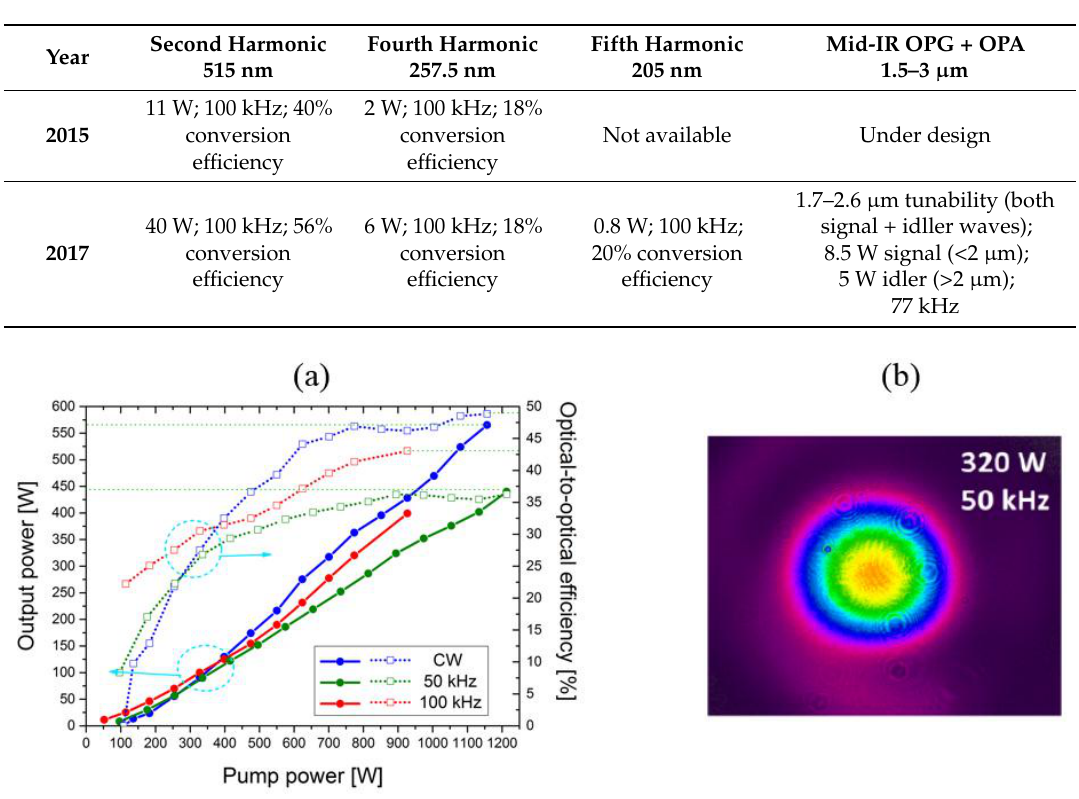
Table 2. Comparison of progress in typical average output power, pulse repetition rate, and conversion efficiency of frequency up- and down-conversion stages pumped by the picosecond Perla C thin-disk laser platform since 2015 [27]. Mid-IR OPG: optical parametric generation producing mid-infrared pulses; Mid-IR OPA: optical parametric amplification amplifying mid-infrared pulses.